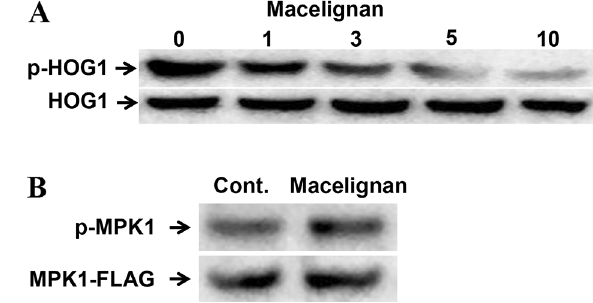
Figure 2. Western blot analysis of HOG1 and MPK1. A , S. cerevisiae was incubated with 1, 3, 5 and 10 m g/mL macelignan for 1 h with 0.4 M NaCl. Proteins were then extracted and detected for phosphorylated and total HOG1. Total HOG1 protein was used as a loading control (Cont.). B , S. cerevisiae with 10 m g/mL macelignan was incubated at 39°C for 2 h to activate MPK1. Proteins were then extracted and detected for phosphorylated and total MPK1. Total MPK1 protein was used as a loading control. Images are representative of at least three independent